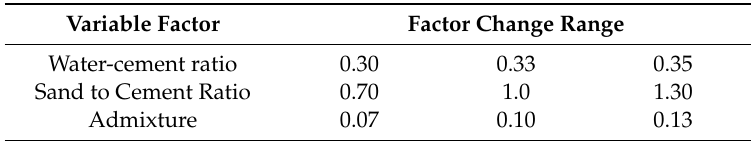
Table 3. Test control factor variation